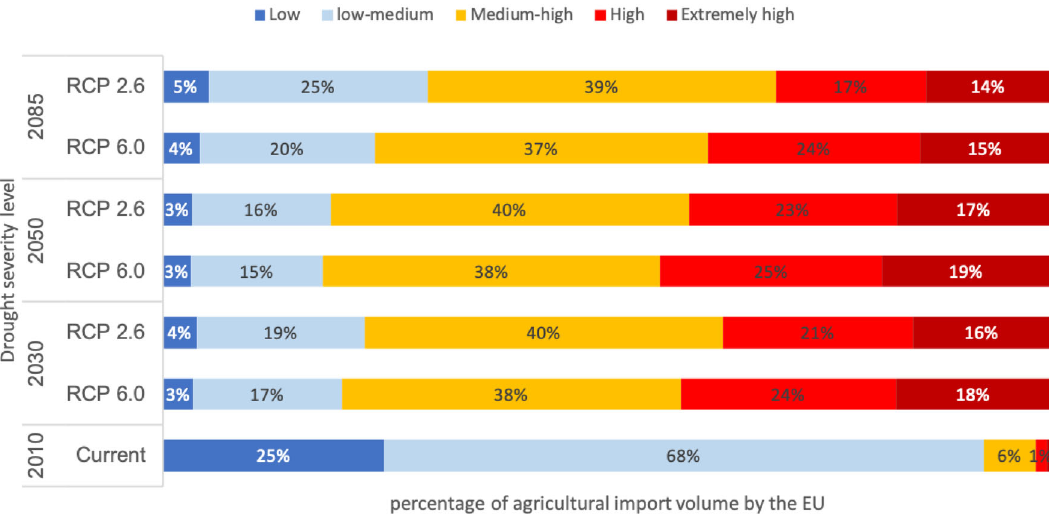
Fig. 3 Percentage of agricultural import volume by the EU categorized by the drought severity levels at exporting locations for different climate scenarios and time slices. Blue to red colors indicates drought severity